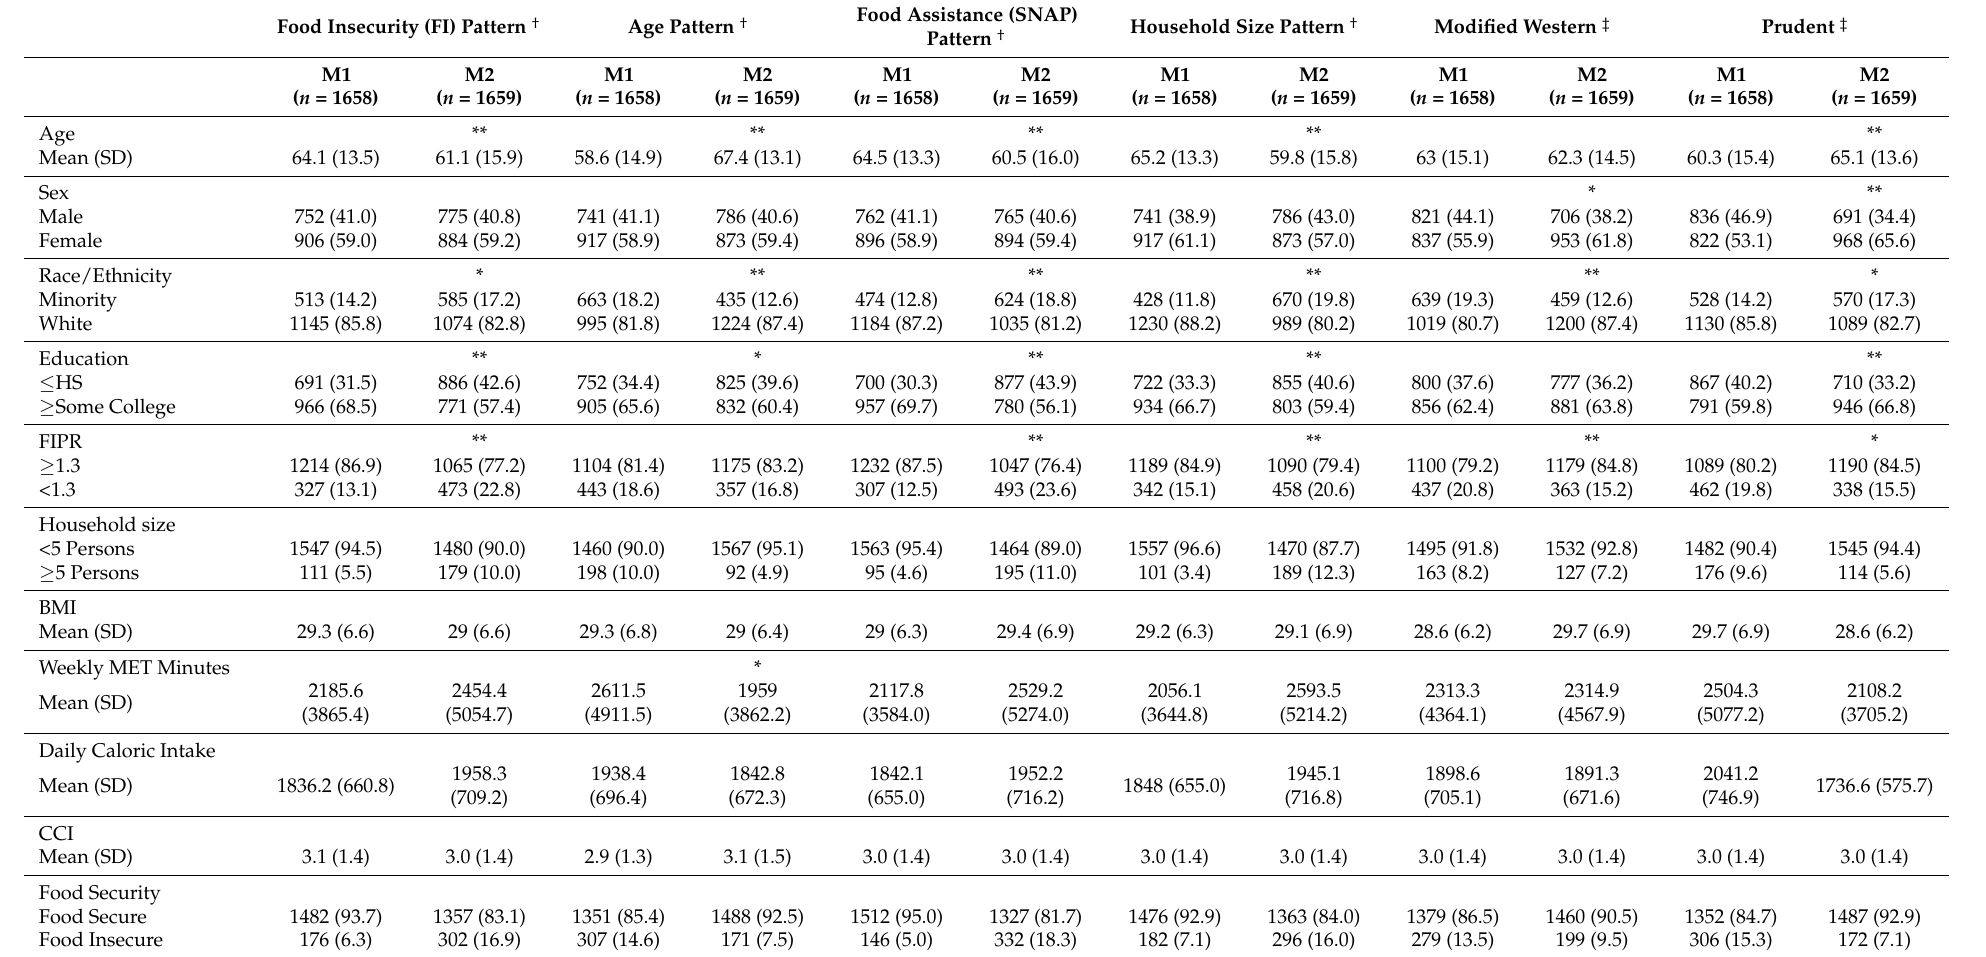
Table 3. Derived dietary patterns and their distributions across study covariates in cancer survivors (subsample A in Figure 1) included in the survival analysis (n =